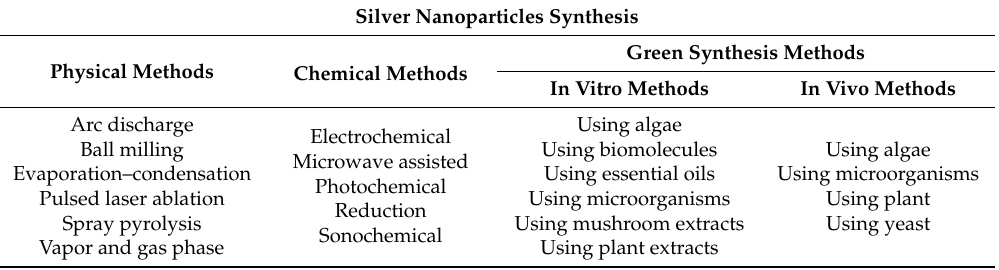
Table 2. Selected techniques for AgNPs